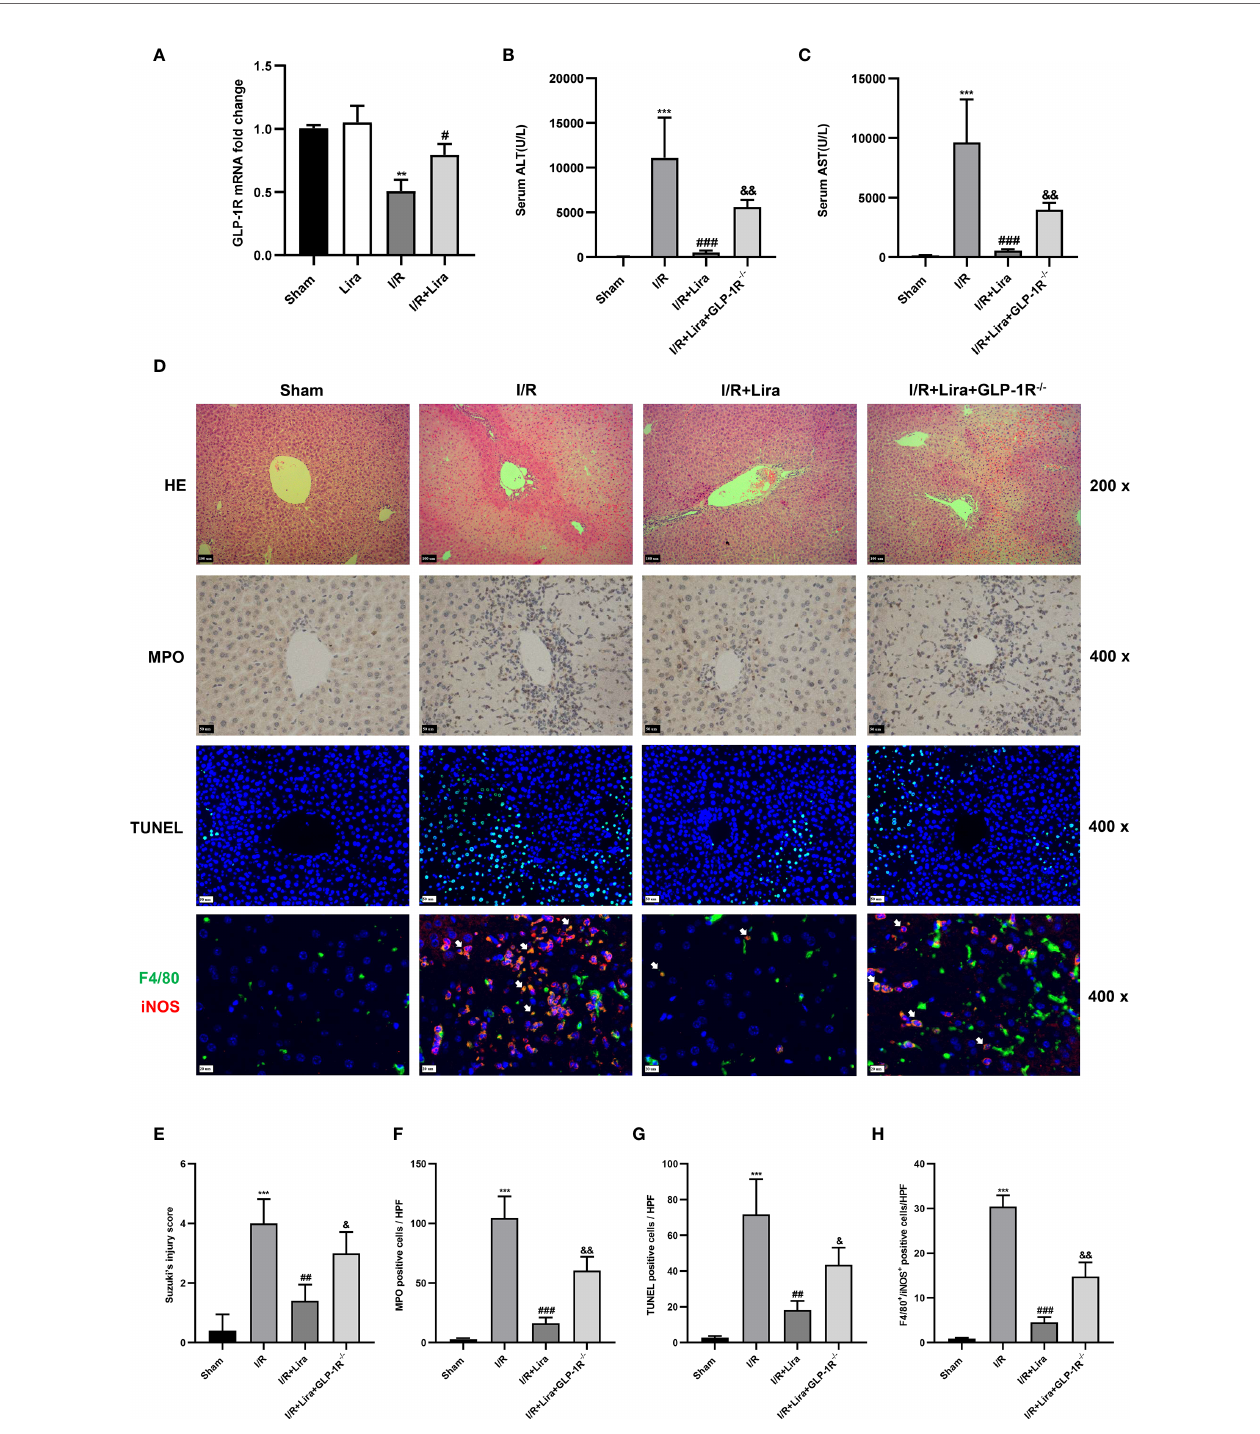
FIGURE 6 | The protective effects of liraglutide on hepatic IRI are partly diminished in GLP-1R - knockout mice. A mouse liver partial IRI model was established using C57BL/6J mice and GLP-1R -/- mice. (A) qRT-PCT was performed to detect GLP-1R expression in KCs from sham-operated, Lira-treated, I/R, and I/R+ Lira-treated groups (n = 3 per group). Serum levels of ALT (B) and AST (C) in each group (n = 4 – 6 per group). (D) Liver injury, neutrophil in fi ltration, hepatocyte apoptosis, and macrophage phenotyping were assessed via H&E staining, MPO, TUNEL assays, and immuno fl uorescence staining, respectively. Quantitation of liver injury (E) , neutrophil in fi ltration (F) , hepatocyte apoptosis (G) , and macrophage phenotyping (H) in each group (n = 3 per group). These results were obtained from at least three independent experiments. All values are expressed as mean ± SD. **P < 0.01, ***P < 0.001 vs. the Sham group; # P < 0.05, ## P < 0.01, and ### P < 0.001 vs. the I/R group. & P < 0.05, && P < 0.01 vs. the I/R+Lira